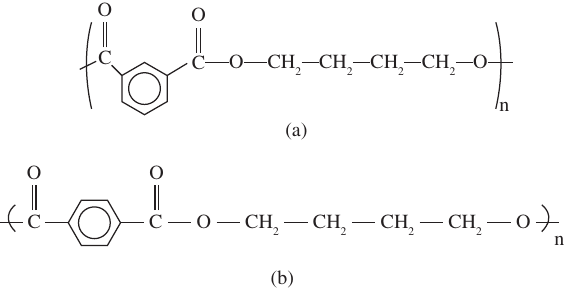
Figure 1. Chemical structure of: a) Poly(butylene isophthalate) and b) Poly(butylene terephthalate) (PBT).